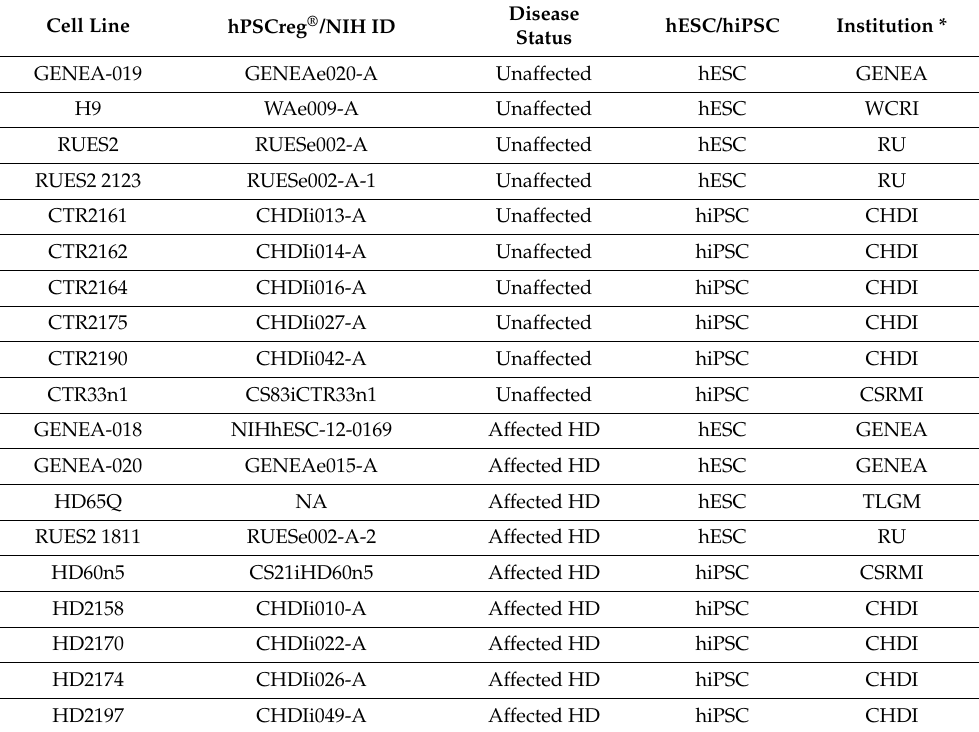
Table 1. List of human pluripotent stem cell (hPSC) lines used for this